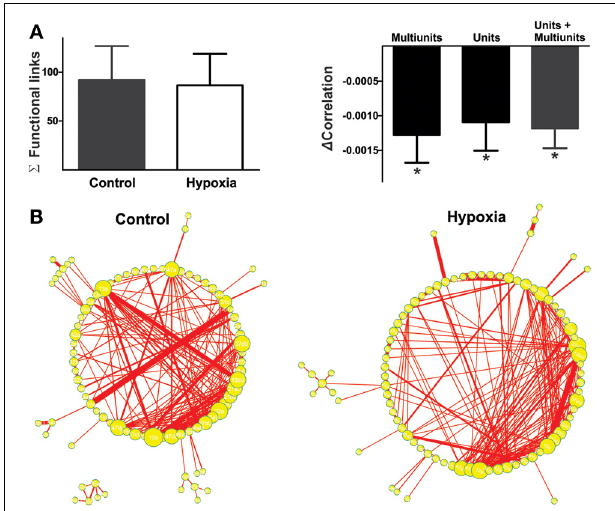
FIGURE 4 | The reconfiguration of the respiratory network in hypoxia does not imply a loss of functional links but a reduction in their strength. (A) Left: Histogram of the number of links in the respiratory network, indicating functional connectivity between elements did not change significantly with hypoxia. Right: Histogram of the change in correlated firing among elements between normoxic and hypoxic conditions, showing a significant reduction in correlation for all classes of respiratory recording elements: multi-unitary, unitary and both ( ∗ p < 0 . 05). (B) Graphic representation of respiratory network configurations in normoxic and hypoxic conditions. Each respiratory element is represented as a circle and each significant correlation between two elements is represented as a connecting line (functional link). The diameter of the circles is proportional to the number of functional links that each element has with other elements in the network. The width of the line is proportional to the correlation value of a given link. Note that the reconfiguration of the respiratory network in hypoxia is not due to a loss in the number of respiratory elements or of their functional links, but to a reduction in the strength of such